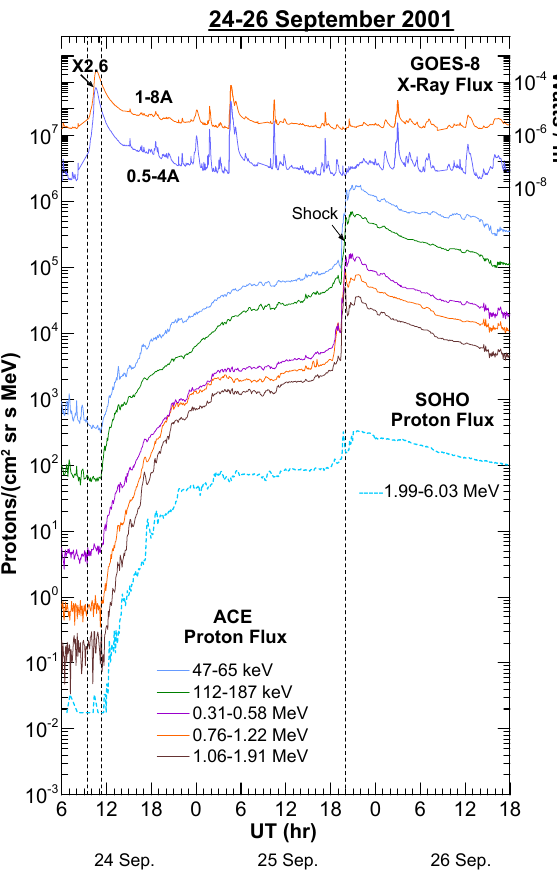
Fig. 8. From top to bottom: IMF | B | , IMF B y , IMF B z , solar wind speed ( V sw ), hourly averaged D st index, 1-min digital magnetic data 1H ABG and 1H TIR for 25–27 September 2001. Red star (*) depicts local